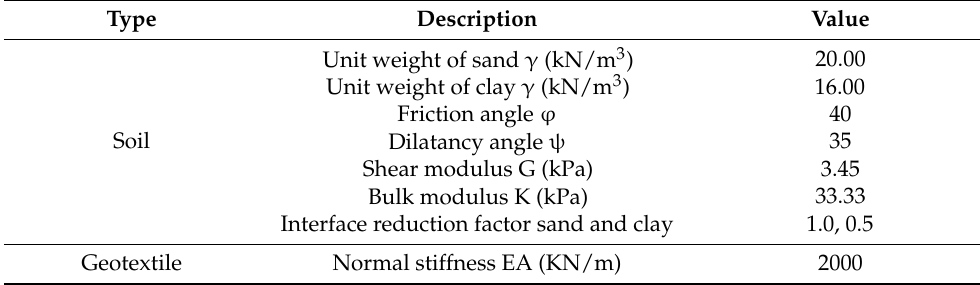
Table 1. Material properties used in the finite difference